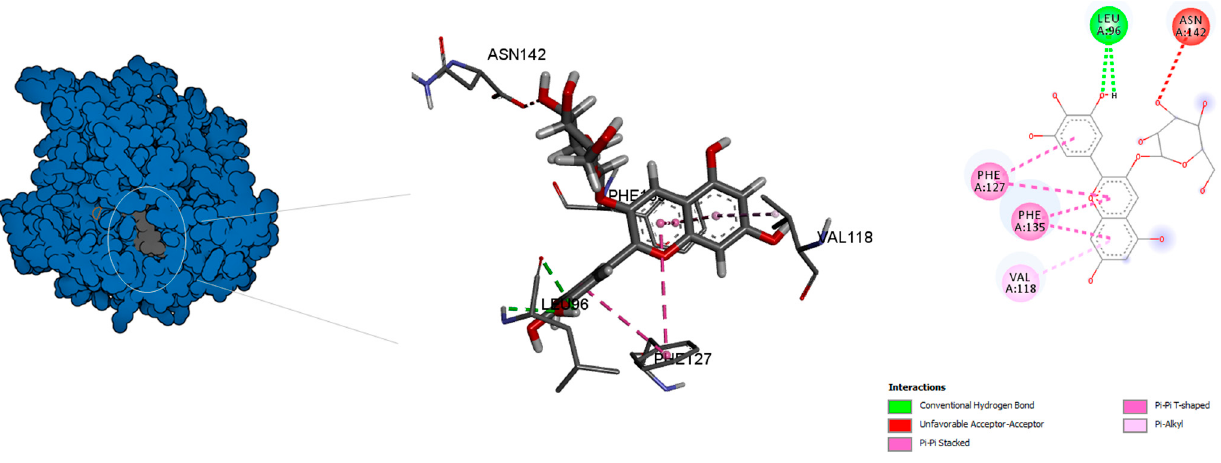
Figure 3. Predicted binding mode for α -tubulin with chlorogenic acid.